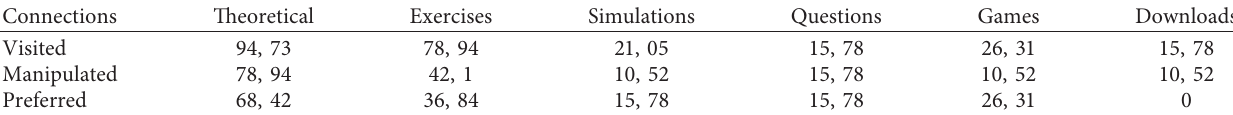
Table 1: Behavior towards site links (in